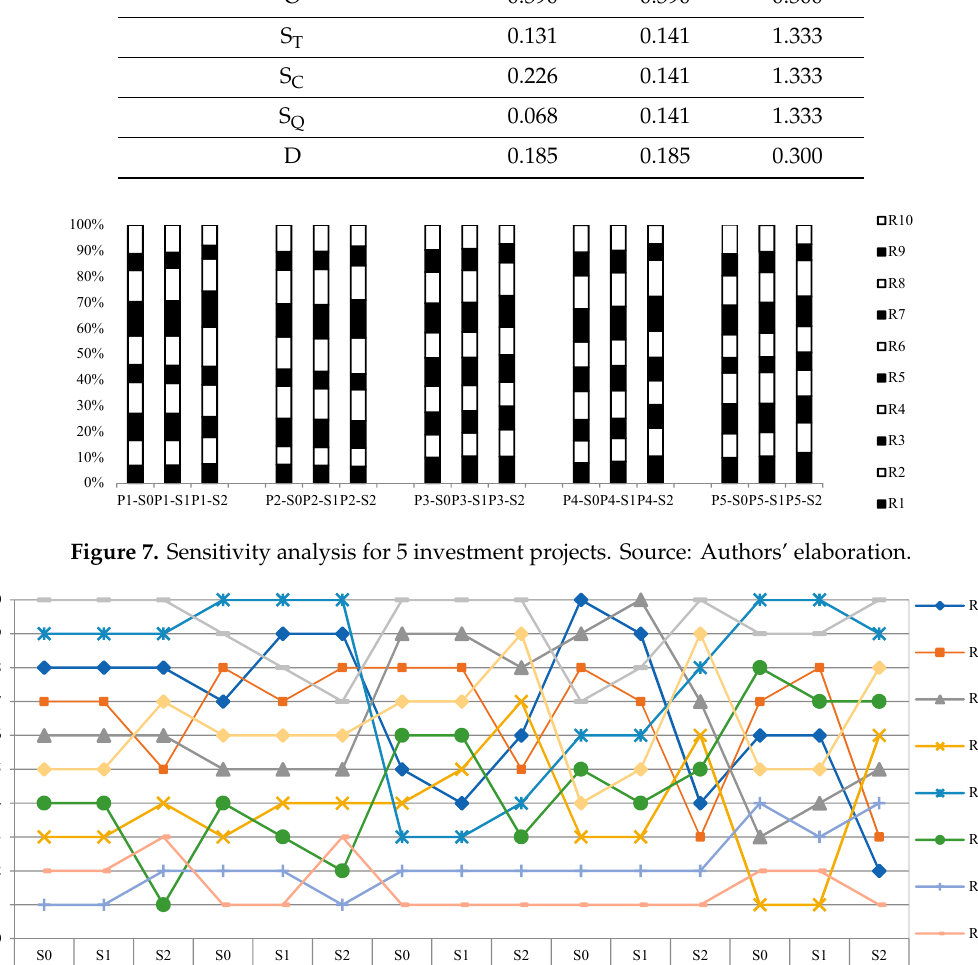
Figure 8. Risks ranking with respect to the considered Statuses .